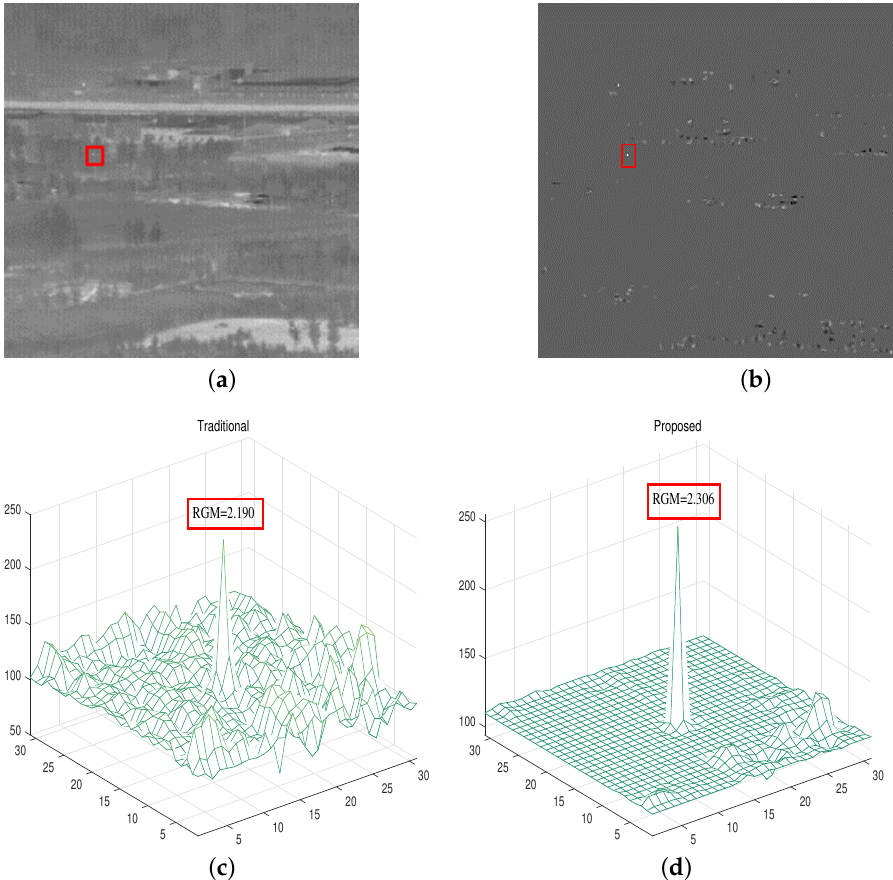
Figure 5. The image is filtered by the proposed method; ( a ) is the original image, ( b ) is the image after smoothing by the preprocessing algorithm, and ( c ) is the traditional RGM after only Laplacian filtering. ( d ) is the RGM obtained by the proposed method.